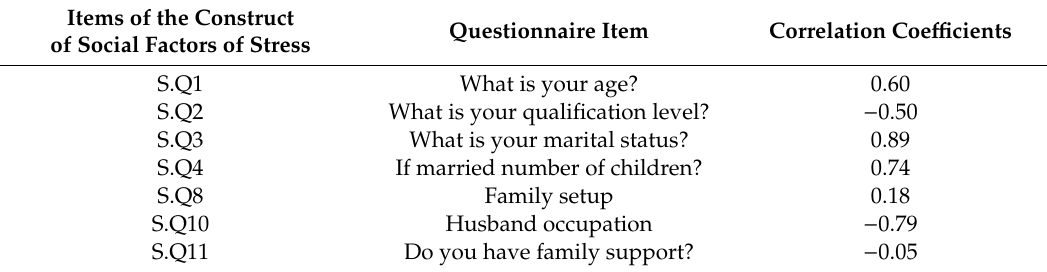
Table 15. Items of the construct of social factors of stress.